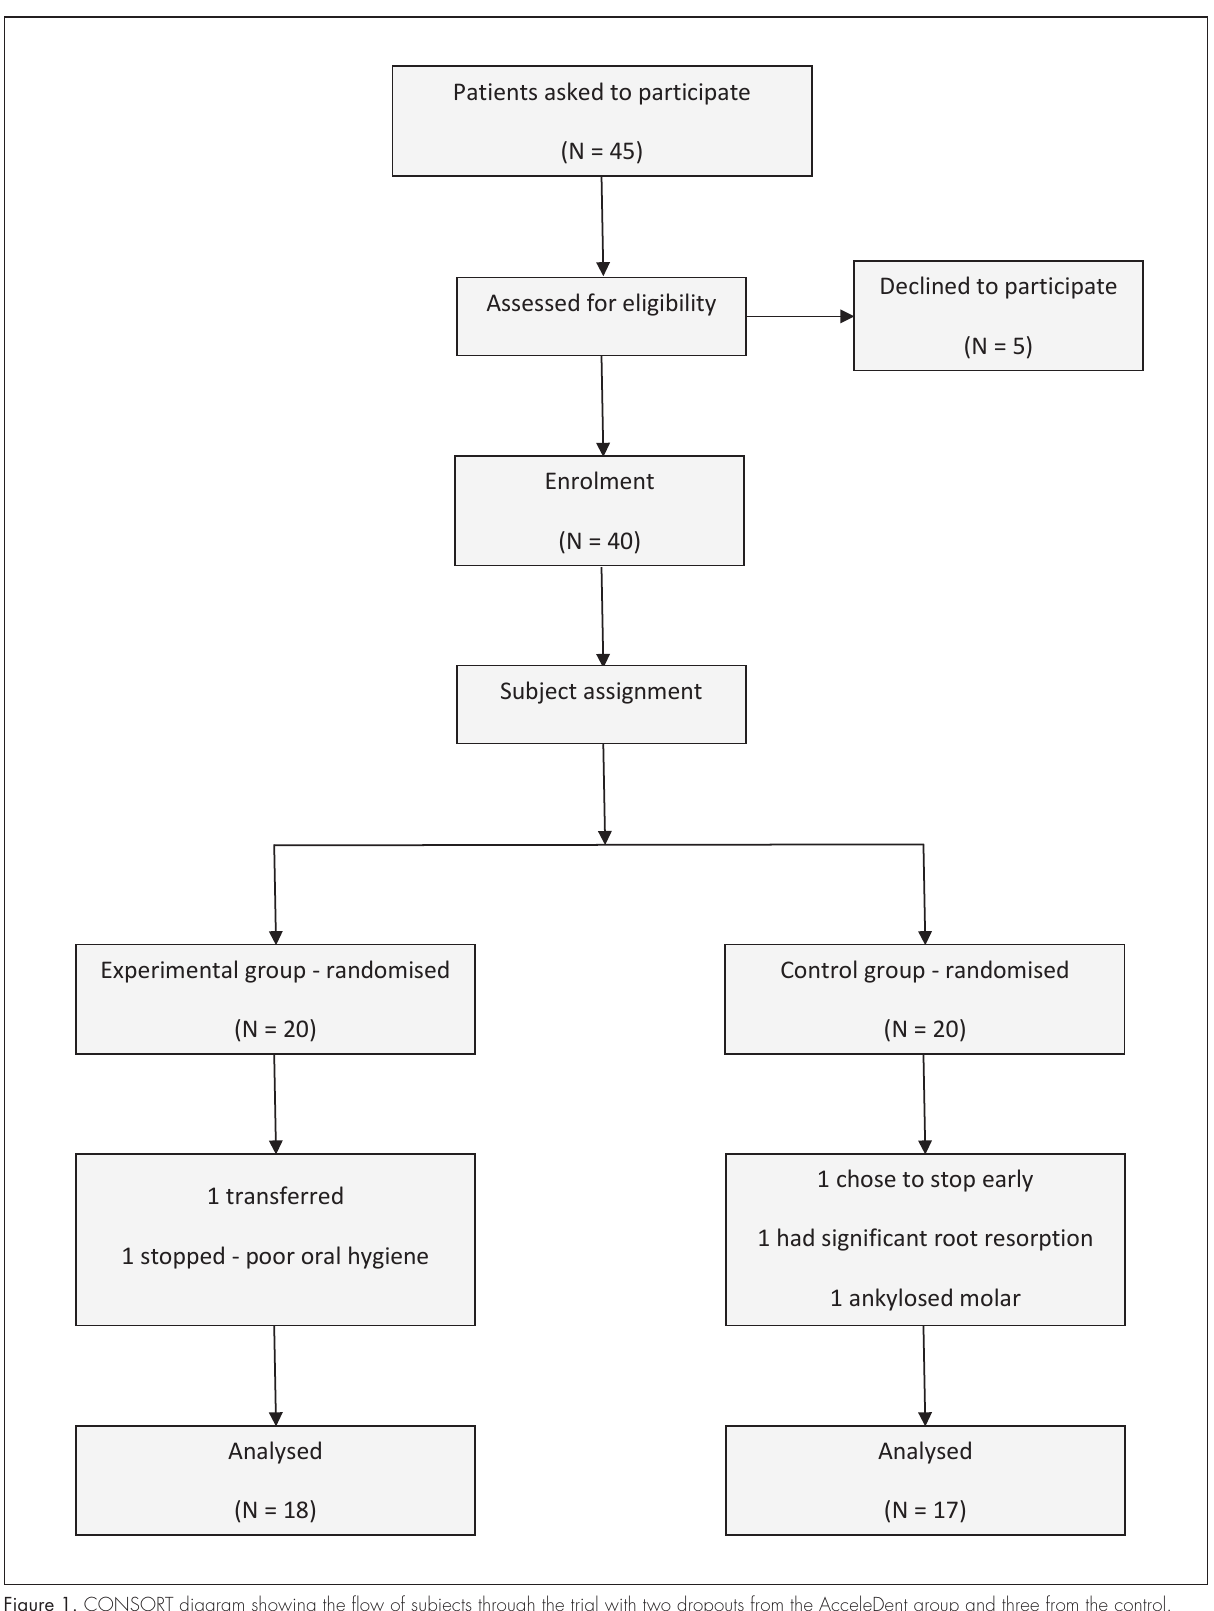
Figure 1. CONSORT diagram showing the flow of subjects through the trial with two dropouts from the AcceleDent group and three from the control.